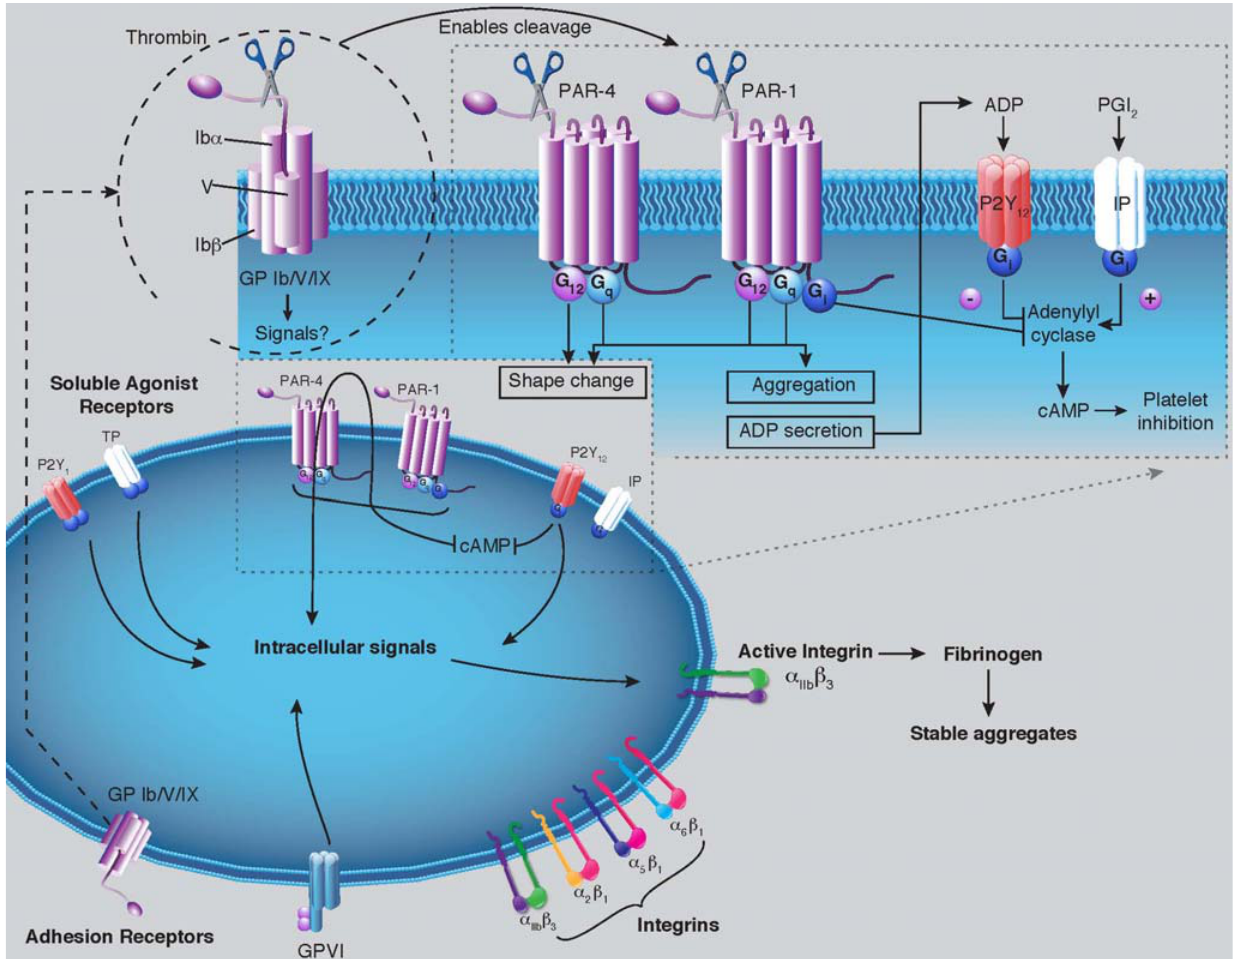
Figure 2. Platelet activation, aggregation and fibrin formation. Platelet activation, aggregation and fibrin production, occur via complex intracellular signaling processes and are regulated by cellular receptors. Platelets adhere to and then are activated by collagen, von Willebrand factor (vWF), and other adhesive proteins. These interactions are triggered when adhesive proteins interact with platelet glycoprotein (GP) receptors, several of which are members of the integrin family. Key GP receptors are displayed above. Platelet activation is reinforced with the release of contents, which includes ADP and other mediators. Thrombin can be generated locally or on the activated-platelet surface. Thrombin then cleaves to the protease-activating receptors (PAR) to expose a tethered ligand that serves to self-bind to PAR, triggering a confirmation that allow interactions with G proteins. PAR-1 couples to Gq protein to stimulate platelet activation. Additional, Gi-coupled pathways attenuate adenylyl cyclase activity, thereby lowering intracellular levels of the platelet inhibitor cAMP. PAR also couples to Gq proteins to stimulate platelet activation. The major platelet receptor GPIIb/IIIa (integrin  IIb  3), mediates the final common pathway of platelet activation by undergoing a conformational change that enables the binding of multivalent ligands, such as fibrinogen and vWF, which cross-link adjacent platelets into